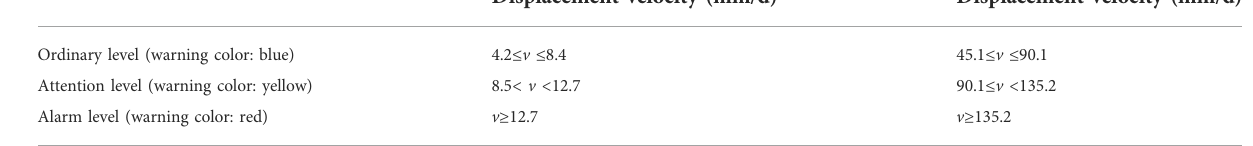
TABLE 5 Landslide early-warning indicators at Wushan. Three warning